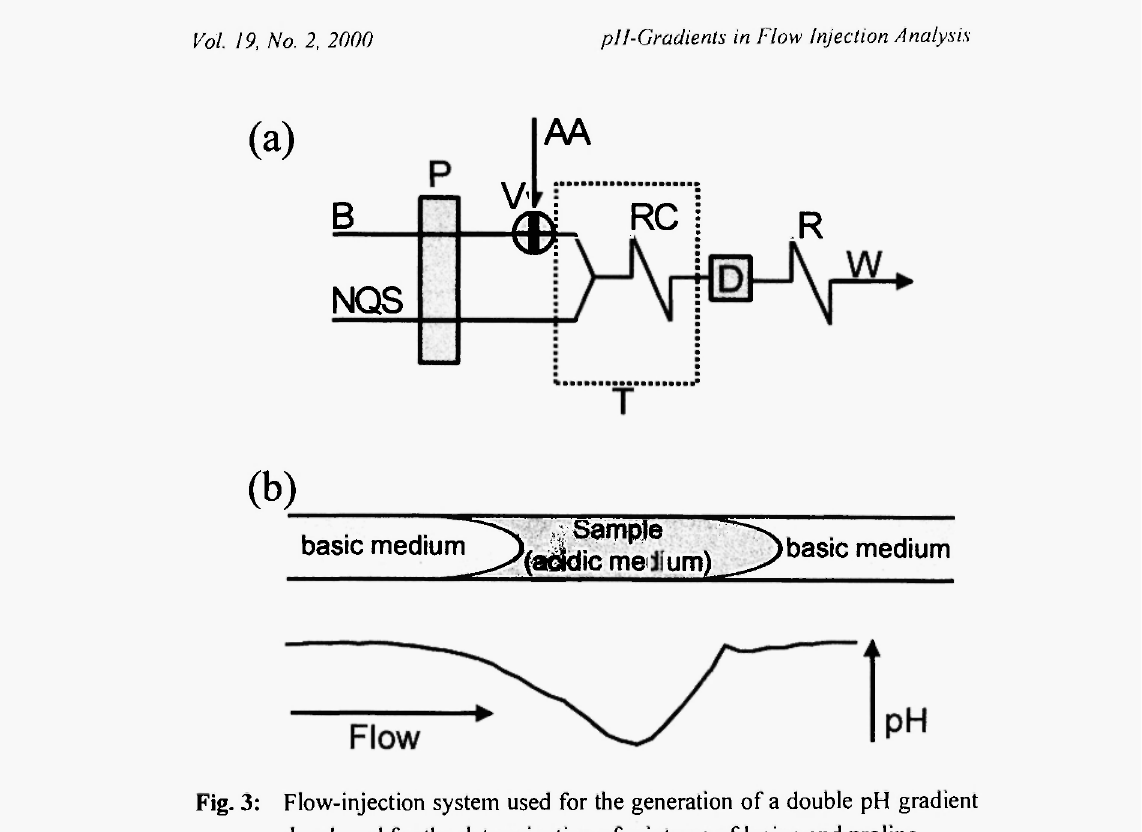
Fig. 3: Flow-injection system used for the generation of a double pH gradient developed for the determination of mixtures of lysine and proline, (a) Scheme of the experimental assembly: Ρ = pump; V = injection valve (injection volume = 150 μΐ). Τ = Thermostatic bath; D = diode array detector; RC = reaction coil (10 m χ 0.5 mm i.d.); R = restrictor (3 m χ 0.35 mm i.d.); AA = sample solution; Β = buffer solution of 0.1 Μ sodium carbonate + 0.03 Μ sodium hydroxide; NQS = 7.5 χ ΙΟ" 4 Μ NQS + HCl 0 . I M ;W = waste. Flow rates: 0.5 ml/min each channel, b) Scheme of the pH gradient